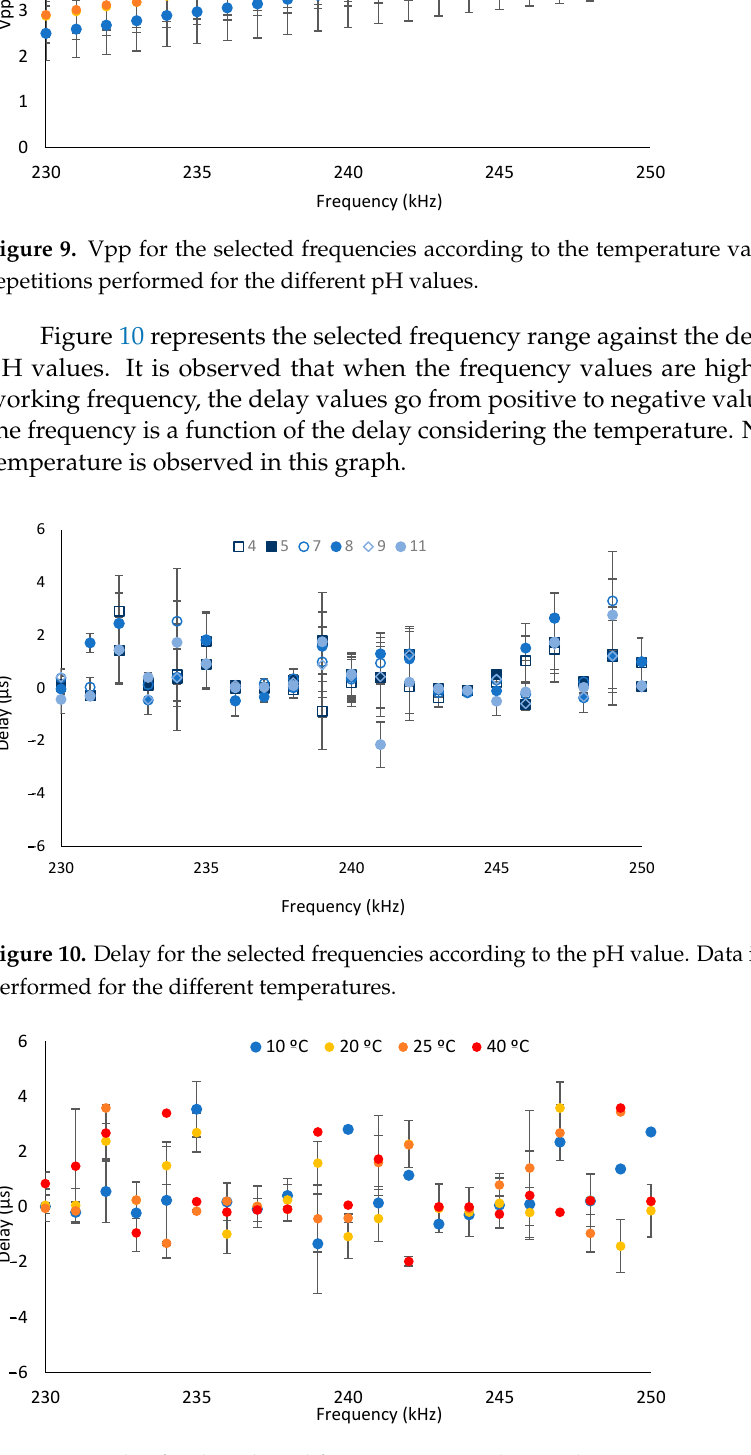
Figure 11. Delay for the selected frequencies according to the temperature value. Data include the repetitions performed for the different pH values.